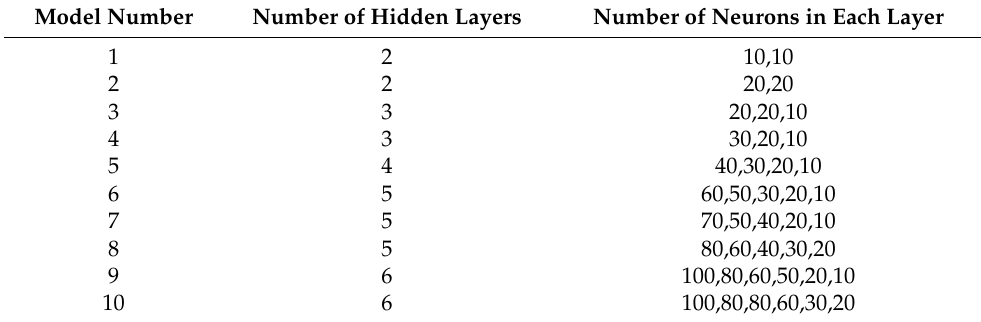
Table 2. Deep learning